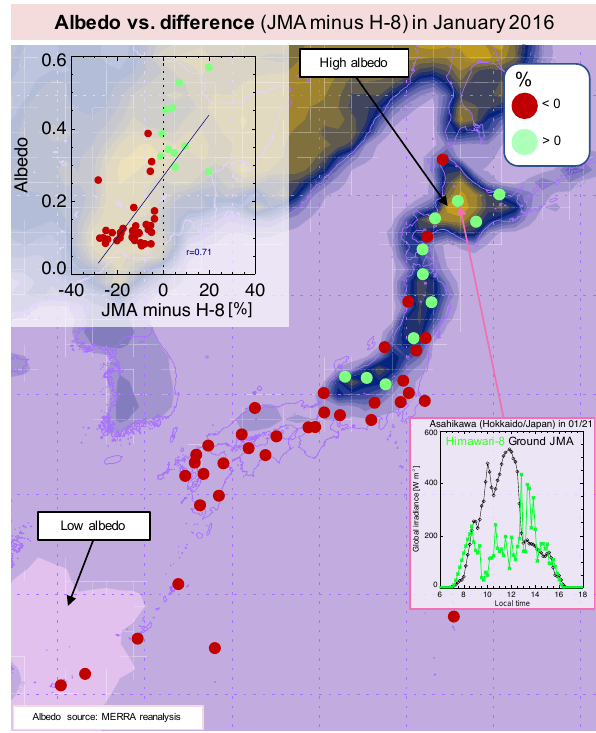
Figure 4. Influence of surface albedo (violet to yellow contour map) on the monthly mean difference between ground observations and Himawari-8 estimates at the stations (points) of the JMA network in January 2016. Top-left inset: scatter plot of albedo and differ- ence values for all stations. In the main panel and the inset negative (positive) differences are shown as red (green) dots. Bottom-right inset: ground-based JMA observations (black line) and Himawari-8 estimates (green line) at Asahikawa (Hokkaido, Japan; see the pink arrow) on 21 January under very high albedo conditions. The origi- nal time step of the comparisons is